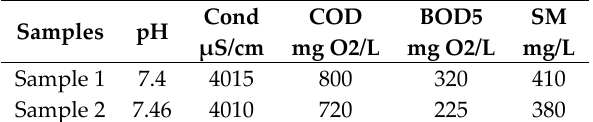
Table 1. The results of physical–chemical analysis of the Boukhalef River waters.